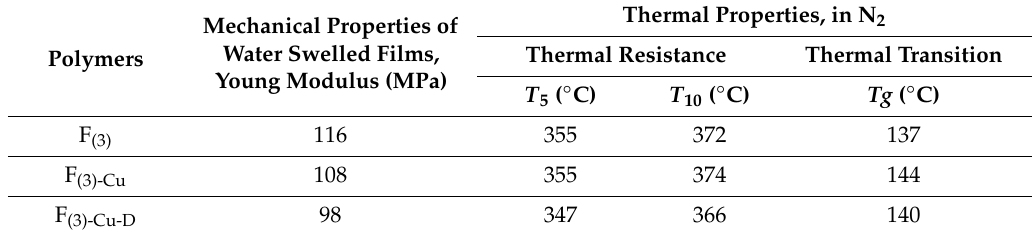
Table 1. Mechanical (Young modulus, MPa) and thermal behaviour (degradation temperatures: